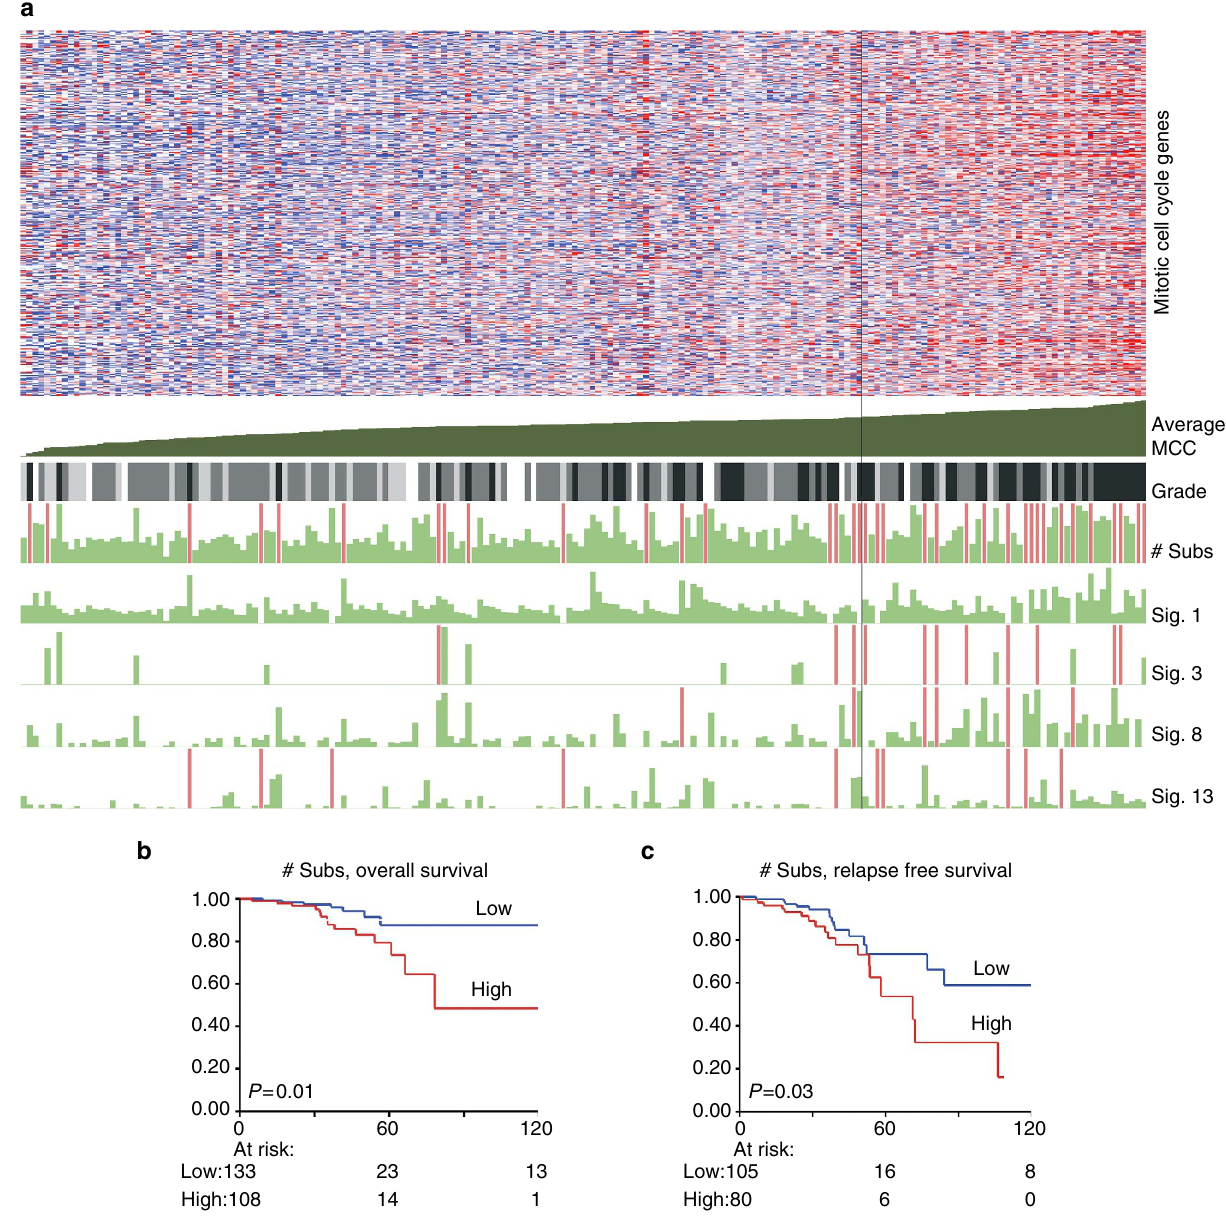
Figure 3 | Mitotic cell cycle gene activity related to mutational signatures and outcome. ( a ) The average expression of genes ( n ¼ 409) from Gene-Ontology term Mitotic Cell Cycle (GO:0000278) were used to rank ER-positive samples. The vertical black line indicates the third quartile border. Top panel: heatmap of median centred expression values in log2-FPKM, red indicates above median, blue below median expression. Genes are in rows, samples in columns. Below the heatmap: ‘Average MCC’ shows the average expression of the cell cycle genes. Grade: pathological grade; white, NA; light grey, grade 1; grey, grade 2; and black, grade 3. Last five rows: the length of the green bar is proportional to the number of substitutions. # subs: the total number of substitutions, samples with 4 10,000 substitutions are shown with a soft-red coloured bar and are of equal length. For the columns labelled Sig. 1, 3, 8 and 13, soft-red indicate samples 4 3,000 of such substitutions. ( b , c ) Overall and relapse-free survival Kaplan–Meier curves. Blue indicates patients with less than the median number of substitutions, red indicates higher than median. P values are logrank-test values. The x -axis shows time in months, y -axis shows the proportion of surviving